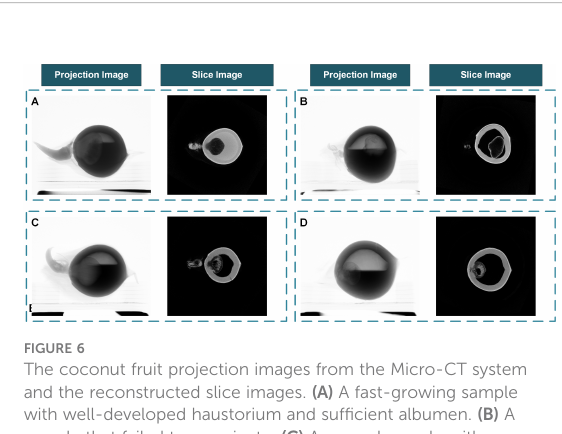
FIGURE 6 The coconut fruit projection images from the Micro-CT system and the reconstructed slice images. (A) A fast-growing sample with well-developed haustorium and suf fi cient albumen. (B) A sample that failed to germinate. (C) A normal sample with a developing haustorium and suf fi cient albumen. (D) A slow- growing sample with insuf fi cient